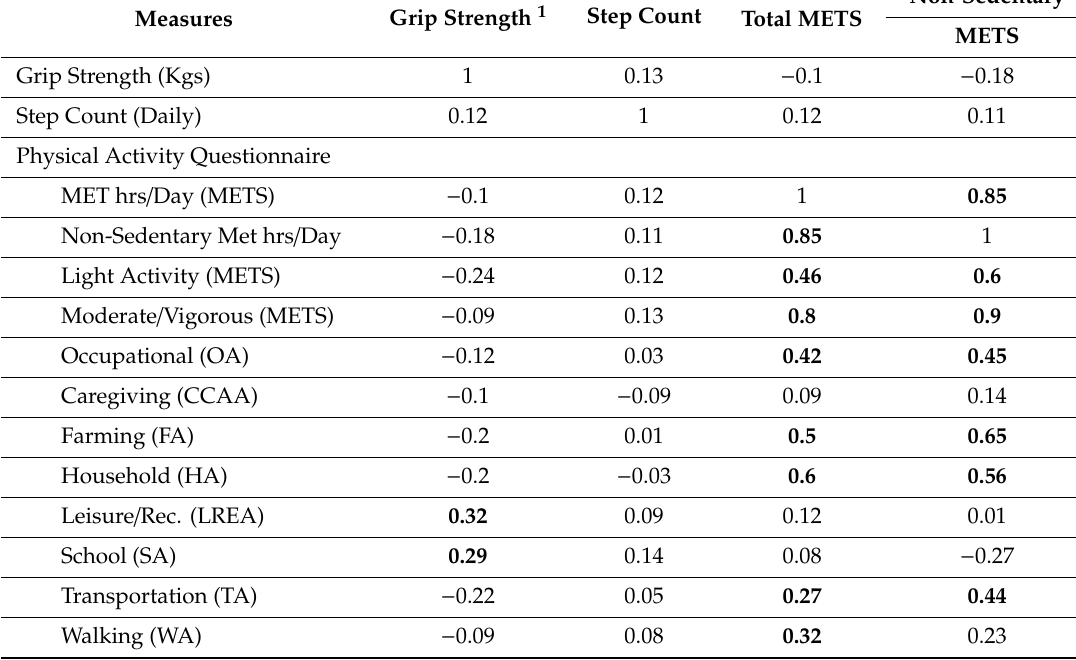
Table 8. Correlations between device-based measures (maximum grip strength in kilograms and average daily step count) and MET hours (per day, in di ff erent activity categories and from light or moderate + activity) based on self-reported physical activity over the past year from PAQ for all participants